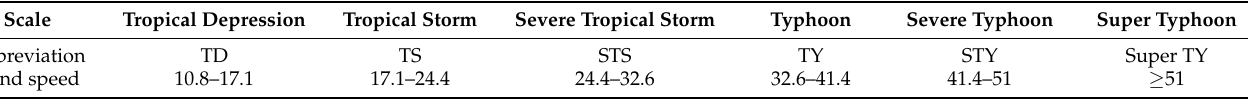
Table 1. Typhoon scales/stages, based on wind speed (in m/s), defined by the